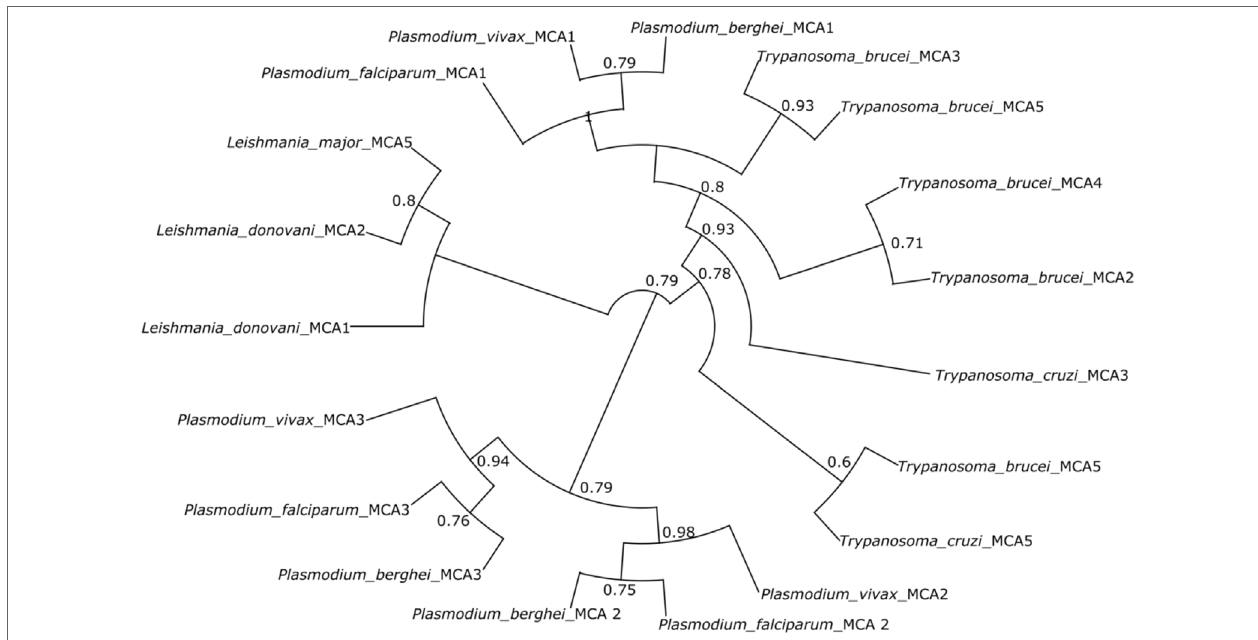
FIGURE 3 | Phylogenetic tree of metacaspases from protozoan parasites. The tree shows the distinct relationship between different metacaspases of the different parasites. The tree was constructed using the maximum parsimony method. Plasmodium metacaspases Pf MCA - 2, 3, Pb MCA - 2, 3, and Pv MCA-2, 3 are phylogenetically distinct from metacaspases-1 of Plasmodium and other parasite